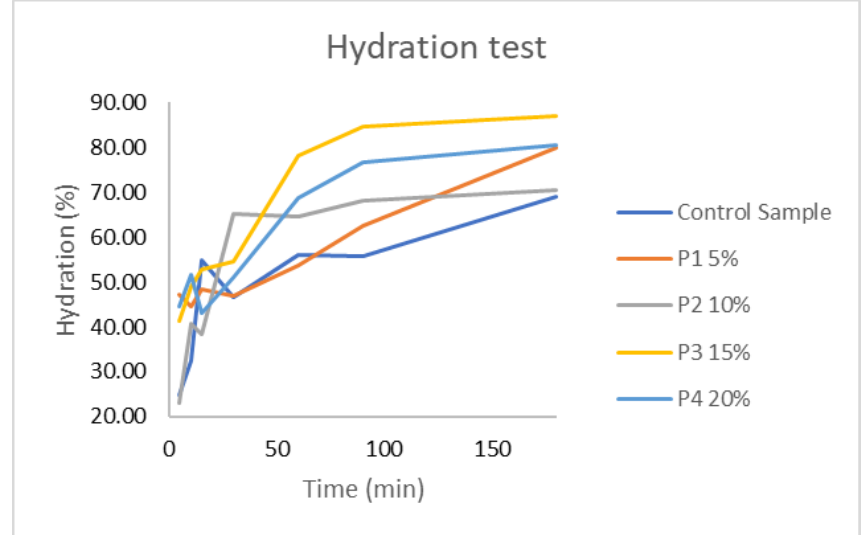
Figure 3. Kinetics of water absorption of pasta at 25 °C.